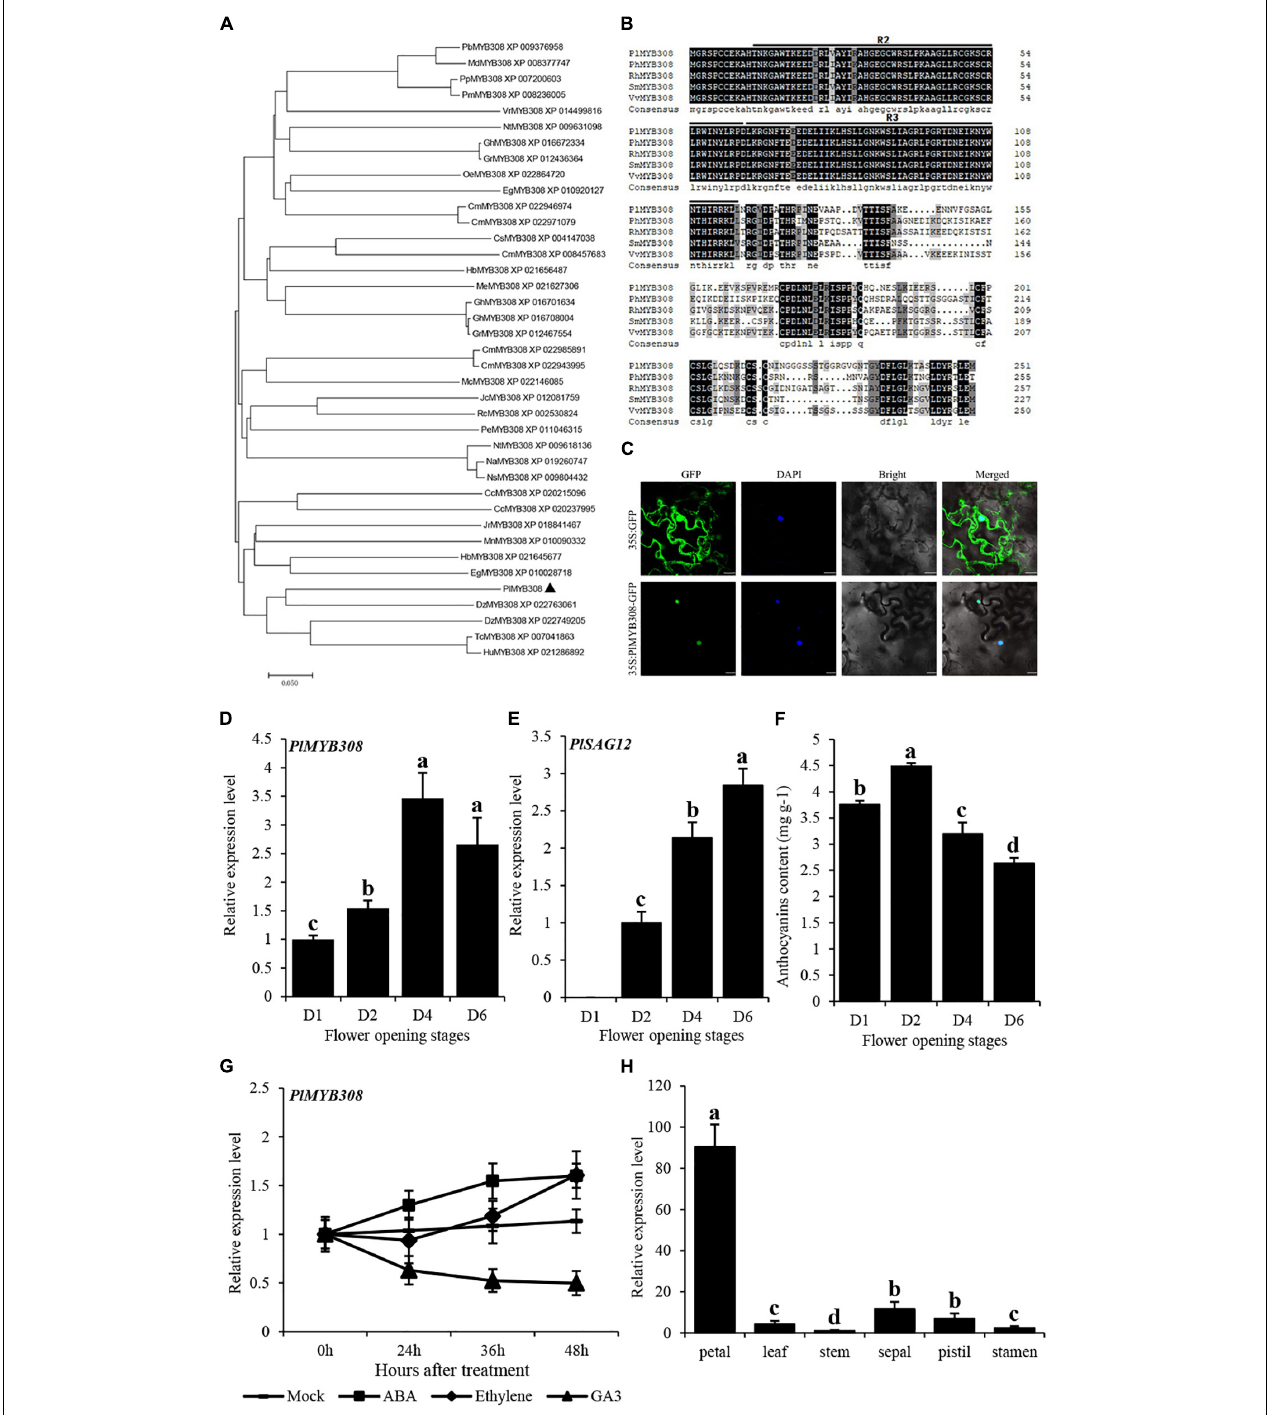
FIGURE 1 | Phylogenetic analysis, homologous sequences, subcellular location, and expression levels of PlMYB308 . (A) Phylogenetic tree generated using various MYB308 protein sequences from Eucalyptus grandis, Ricinus communis, Fragaria vesca L. and other plant species. Bootstrap values indicated the divergence of each branch, the scale indicated branch length. (B) Homologous sequences compared using various MYB308 protein sequences from Paeonia lactiflora, Petunia hybrida, Salvia miltiorrhiza , and Vitis vinifera . (C) Subcellular localization of GFP fusion of PlMYB308. Scale bars = 20 µ m. (D,E) Quantitative RT–PCR analysis of PlMYB308 and PlSAG12 expressions in herbaceous peony petals at various opening stages. PlUB was used as an internal control. (F) The anthocyanin content at various flower opening stages were determined. (G) Expression levels of PlMYB308 under hormones treatment. Herbaceous peony flowers harvested at anthesis then placed in tubes with water (mock), 0.1 mM ABA, 0.2 mM ethephon, and 50 µ M GA3. (H) Relative expression levels of PlMYB308 in different tissues. Error bars showed SD of the means of three biological replicates. a, b, c, and d indicated significant difference at p ≤ 0.05 level by Duncan test. Error bars show SD of the means of three biological